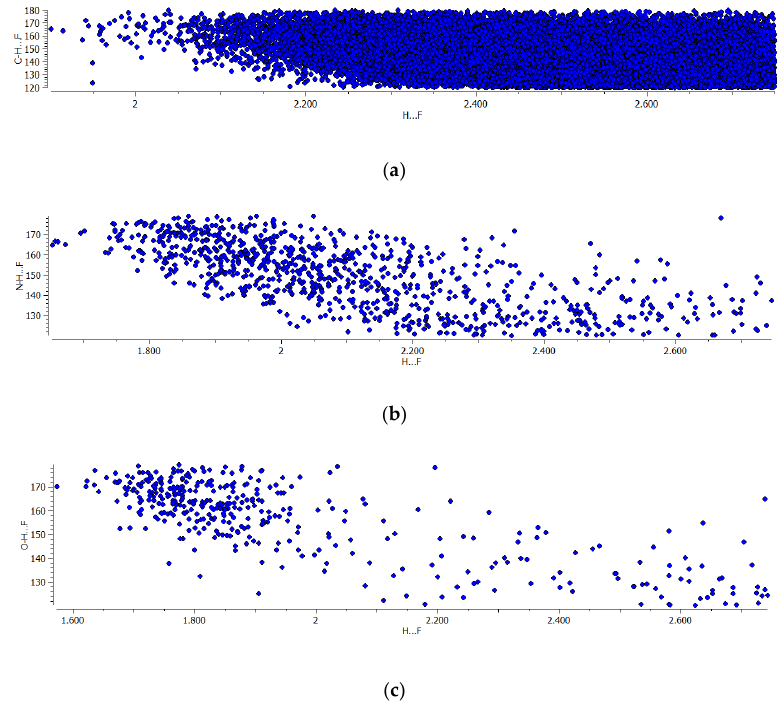
Figure 4. The scatterplots H ... F distance vs. A-H ... F angle for systems of three samples taken from CSD and considered in this study ( a ) A = C, ( b ) A = N and ( c ) A =